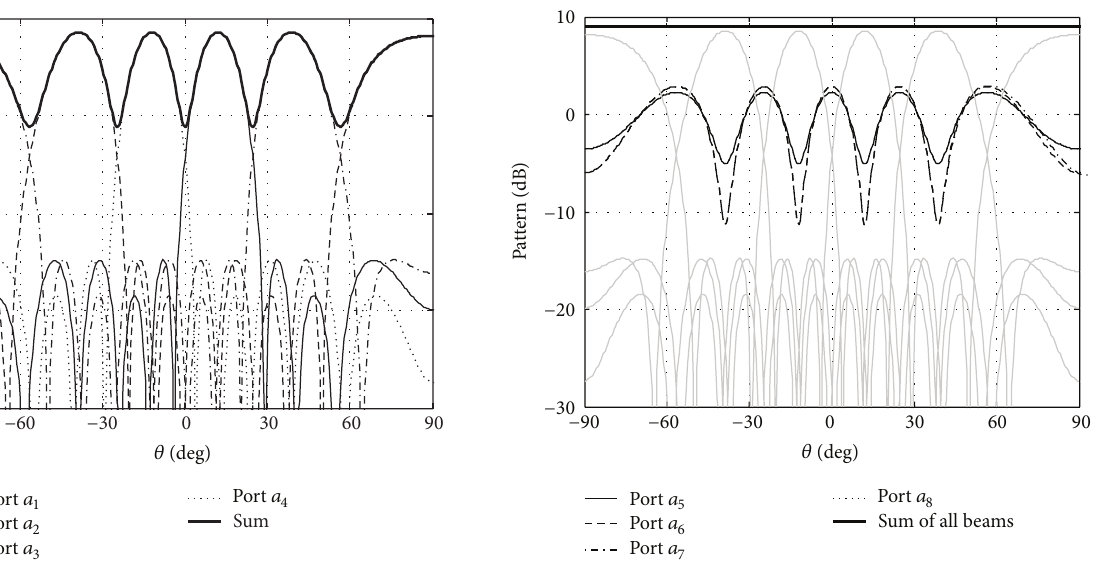
Figure 7: Radiation patterns of a 4 × 8 Nolen matrix with tapered amplitude distribution.